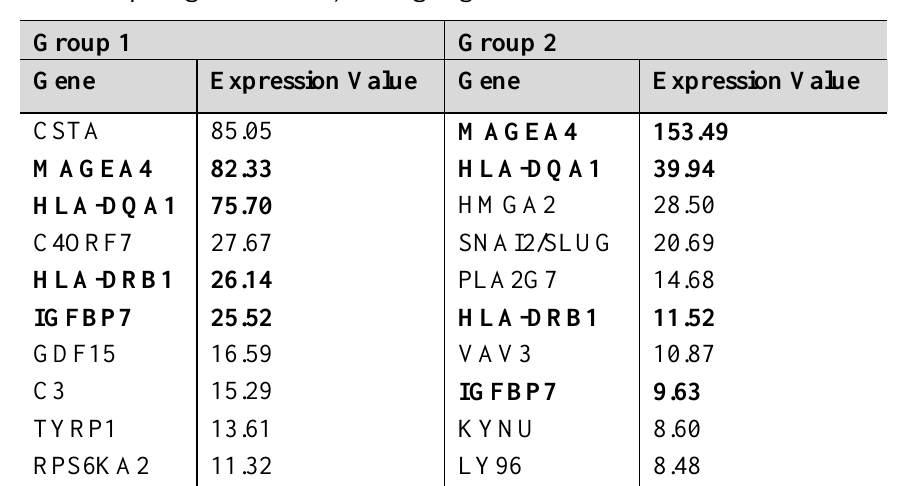
Table 2. Top-regulated transcripts. Genes that are regulated in both, non-infected (Group 1) and infected (Group 2) glioma cells, are highlighted